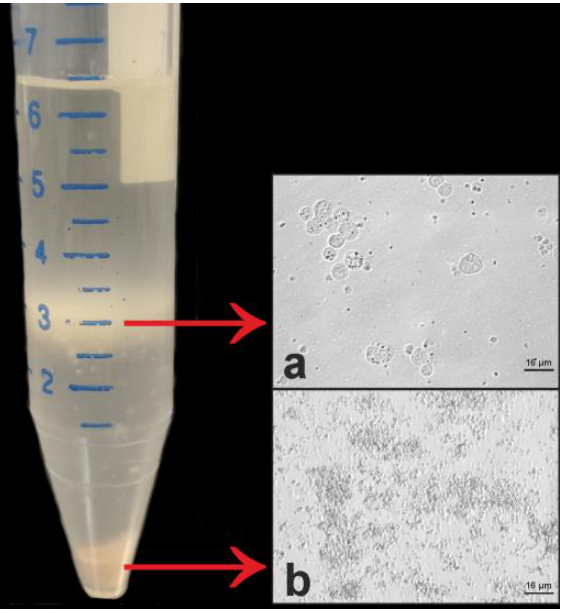
Figure 2. Micrographs of testis sections of meagre immunostained with ( a ) anti-oct4 antibodies (Trial 1) and ( b ) anti-vasa antibodies (Trial 2). Intralobular positive cells (arrowheads) are stained in brown. In ( b ), Mayer’s haematoxylin was used as a nuclear counterstain. Magnification bars = 20 µ m.